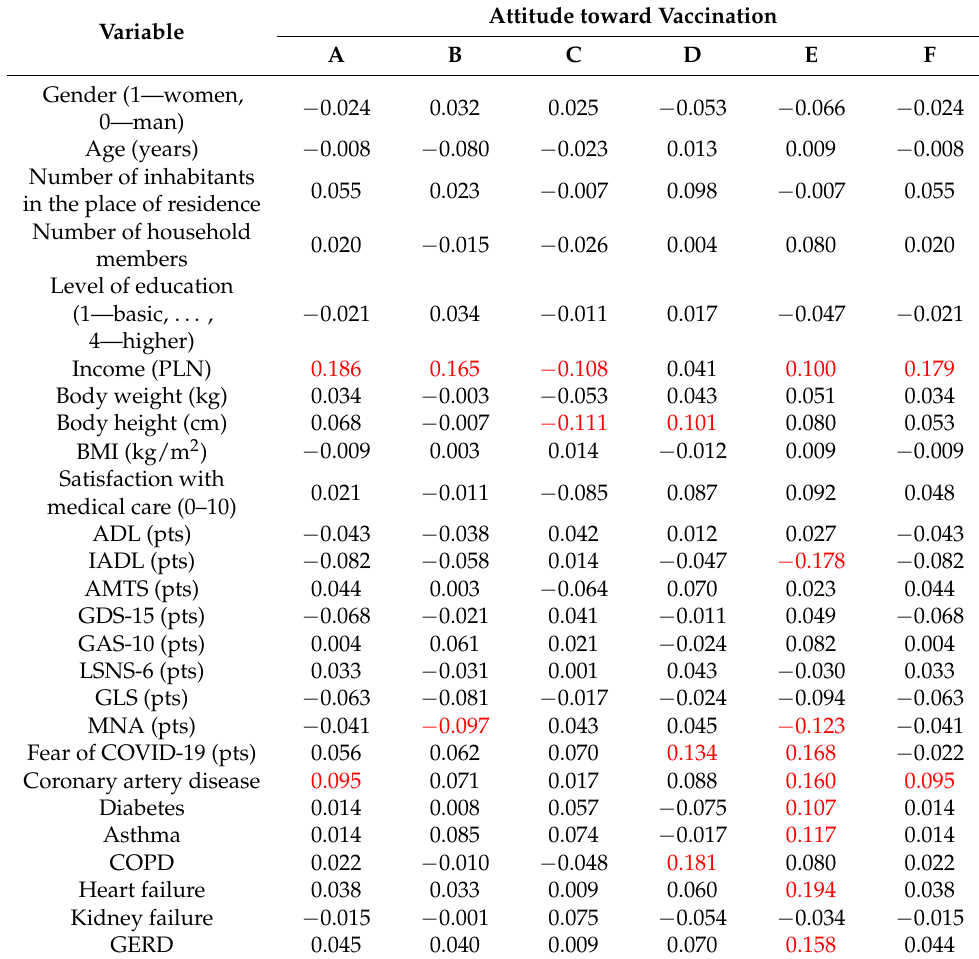
Table 1. Values of Spearman’s rank correlation coefficients (Rho) between the analyzed sociodemo- graphic, clinical, and mental factors and attitudes toward preventive vaccination in the group of 500